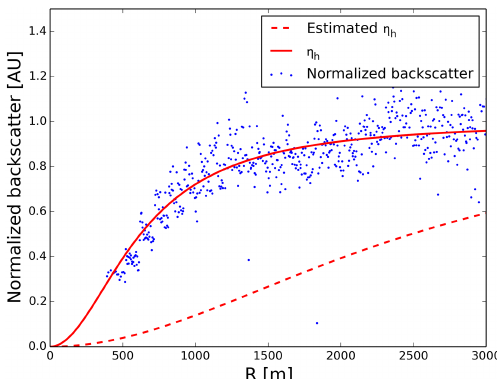
Figure 4. Estimated (red, dashed) and derived (red, solid) het- erodyne efficiency η h as a function of range R . The normalized backscatter data points (blue dots) correspond to the averaged backscatter power corresponding to range gates at altitudes between 4.5 and 5km for a flight altitude between 5.5 and 8km during the flights on 22 June and 11